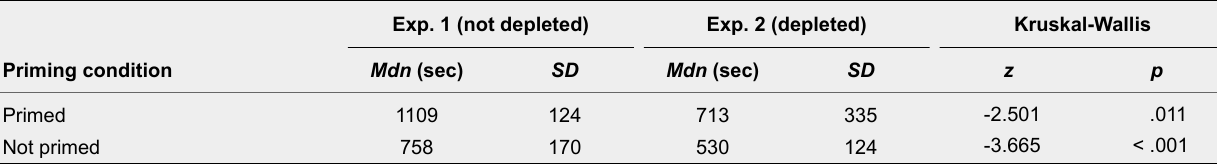
Comparison of Medians Between the Groups in the Two Experiments Exp. 1 (not depleted) Exp. 2 (depleted) Kruskal-Wallis Priming condition Mdn (sec) SD Primed